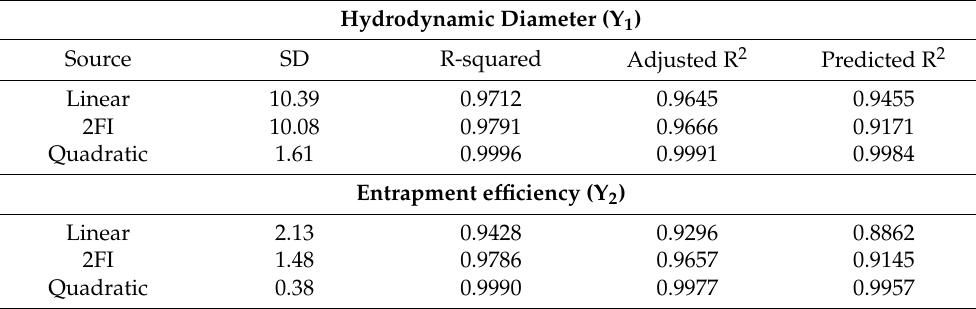
Table 3. Statistical summary of experimental design